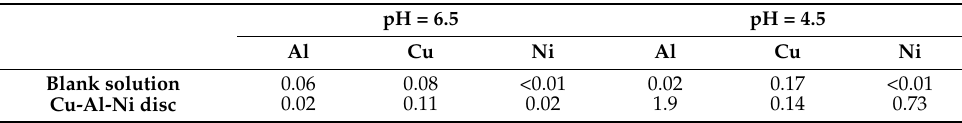
Table 3. Al, Ni, and Cu ions’ concentrations in artificial saliva pH = 6.5 and pH 4.5 after 7 days of immersion (values are given in µ g/cm 2 ).